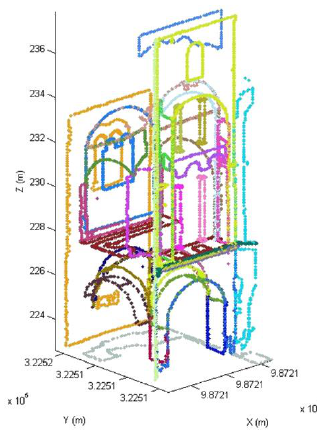
Figure 13. Contour points extraction based on the segments of Figure 7b